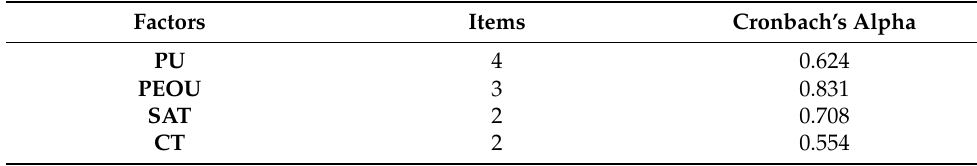
Table 4. Reliability of the factors.